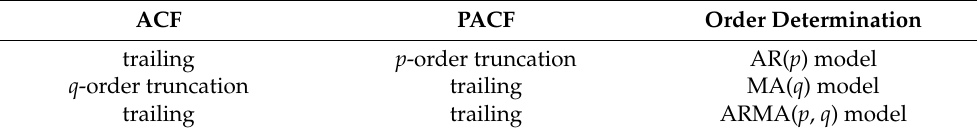
Table 1. Criterion for order determination of ARMA